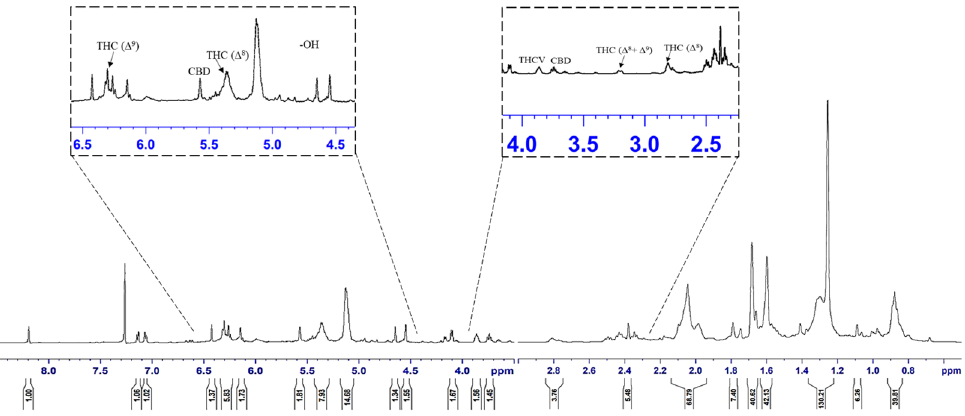
Figure 5. 1 H NMR spectra of cannabis oil extracted using SCCO 2 . Table 7. Peak assignments for 1 H NMR spectrum of cannabis oil obtained from SCCO 2 extraction.